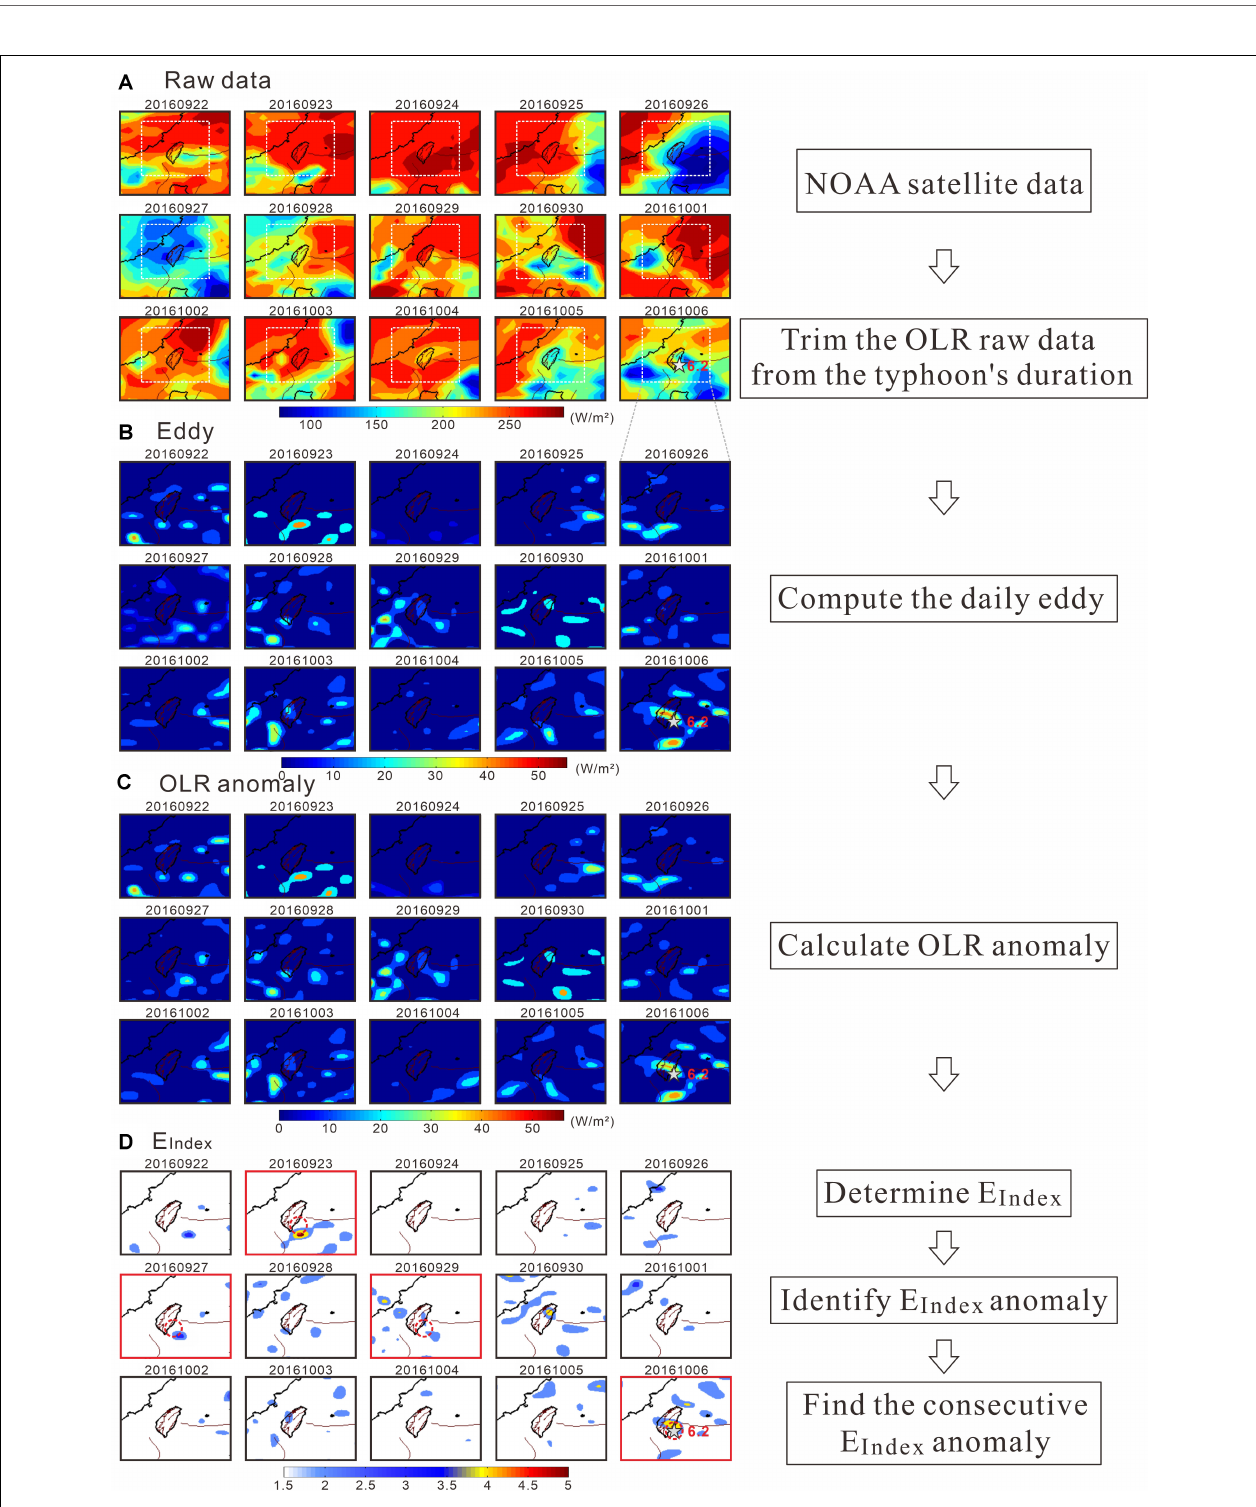
FIGURE 2 | Flowchart of the methodology and procedure for extracting E Index from OLR daytime data observed by the NASA-18 satellite during the period from Sept. 22 to Oct. 6, 2016: (A) the raw data of the OLR, (B) eddy, (C) OLR anomaly, and (D) E Index . The epicenter of the M6.0 2016/10/06 earthquake is marked with a gray star. This shows an example of the abnormal E Index anomaly (EA) within the epicenter’s vicinity with a red circle for September 23, 27, 29, and October 6 for Event 30 in southwest Taiwan.